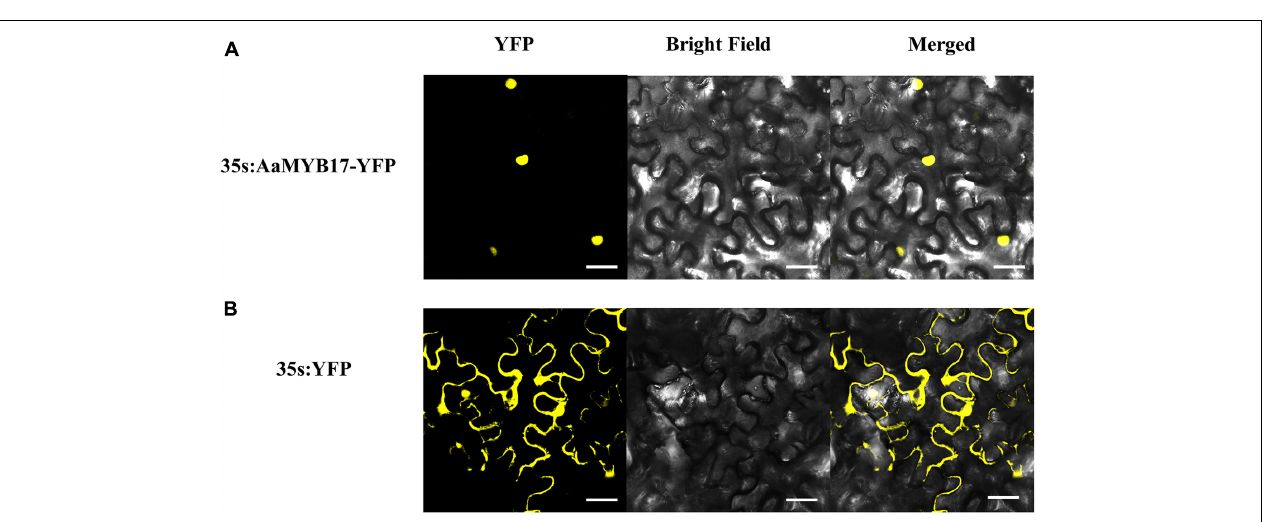
FIGURE 3 | The subcellular localization of AaMYB17 in leaves of N. benthamiana . (A) Localization of AaMYB17 protein fused with YFP. (B) Localization of empty vector. Bars = 40 µ